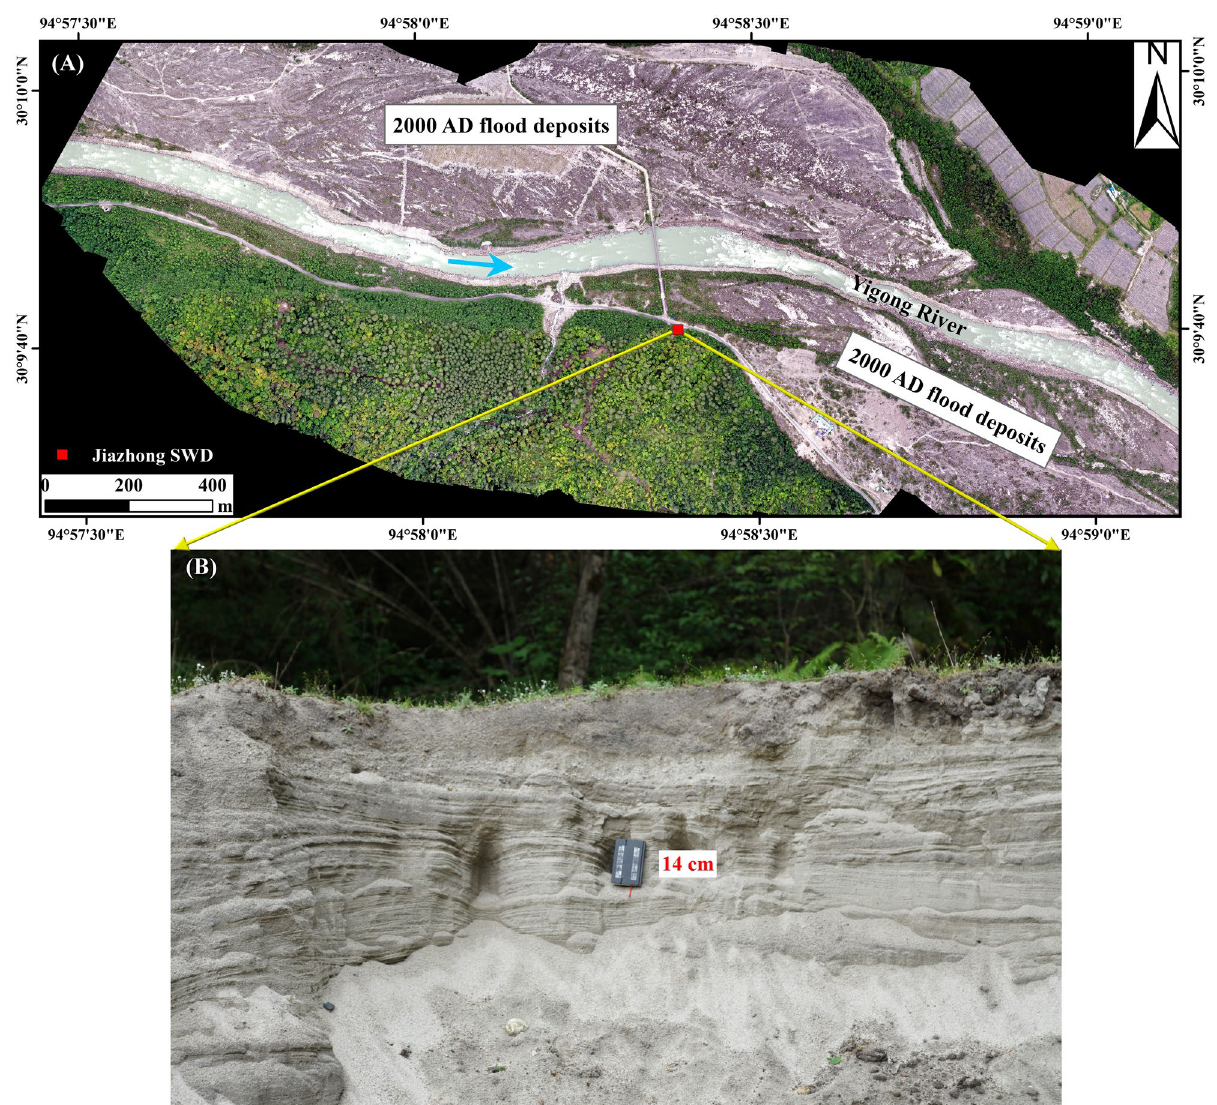
Figure 4. ( A ) Location of slackwater deposits (SWDs) on the opposite bank of Jiazhong Village. Orthographic image taken on May 11, 2020, by the Dajiang unmanned aerial vehicle (UAV). ( B ) Exposed sedimentary section of the SWDs. The notebook is 14 cm